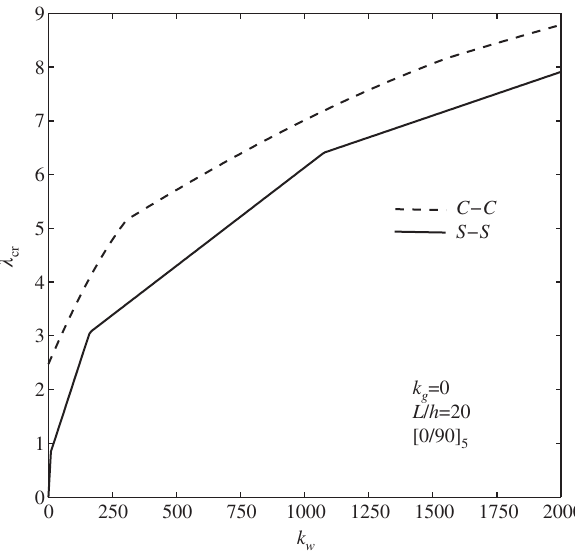
Figure 1 Influence of the Winkler constant of elastic foundation on λ